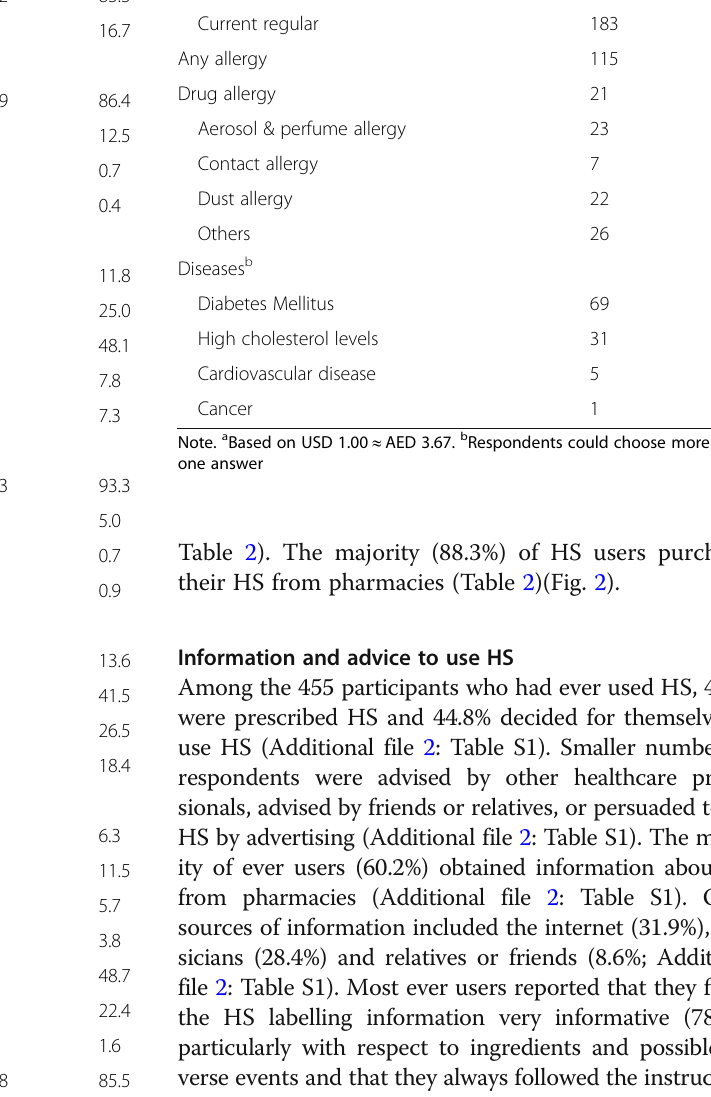
Table 1 Characteristics of participants, cross-sectional study